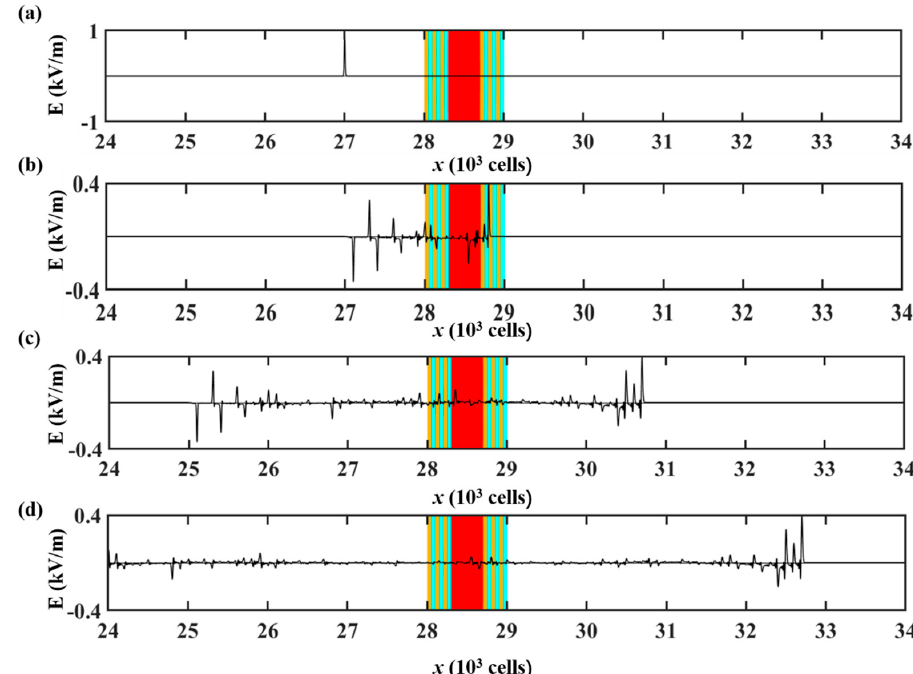
Figure 8. Snapshots of the electric field of an incident Gaussian pulse propagating in air and incident upon a 1D plasma PhC with a defect layer thickness of DL = 4 d at different times: ( a ) 0, ( b ) 15.3, ( c ) 30.6, and ( d ) 45.9 fs. The properties of the plasma layer are ω p = 2.0 THz, ϑ c = 50 GHz.